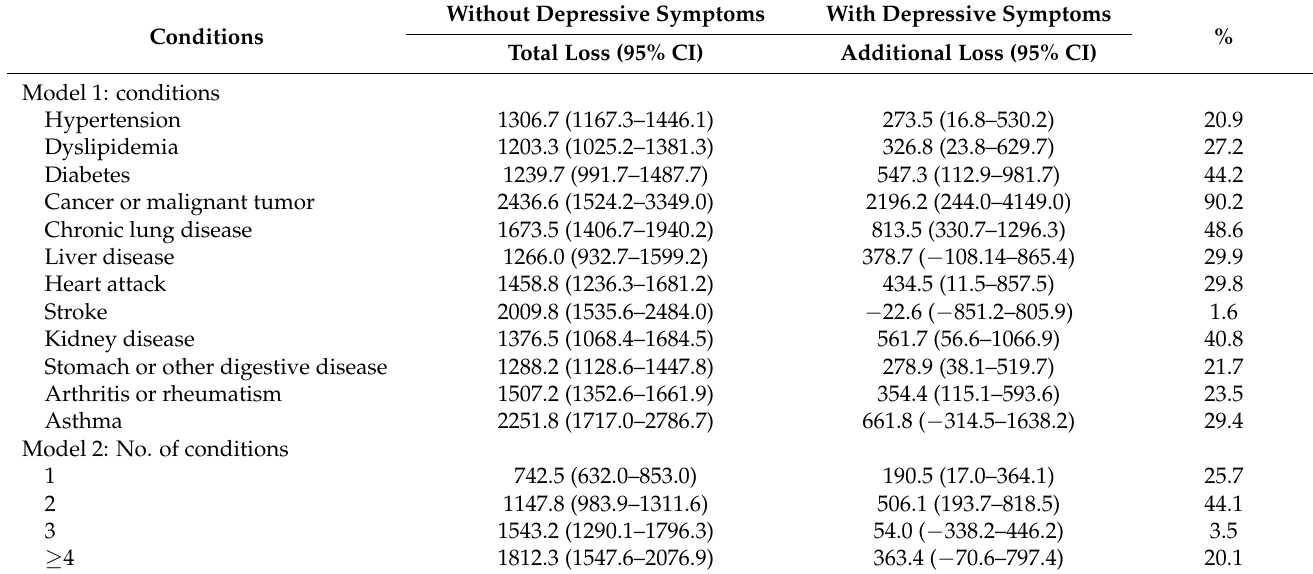
Table A3. Comparing the proportion of productivity loss associated with depressive symptoms to total productivity loss of patients without depressive symptoms in 12 common chronic